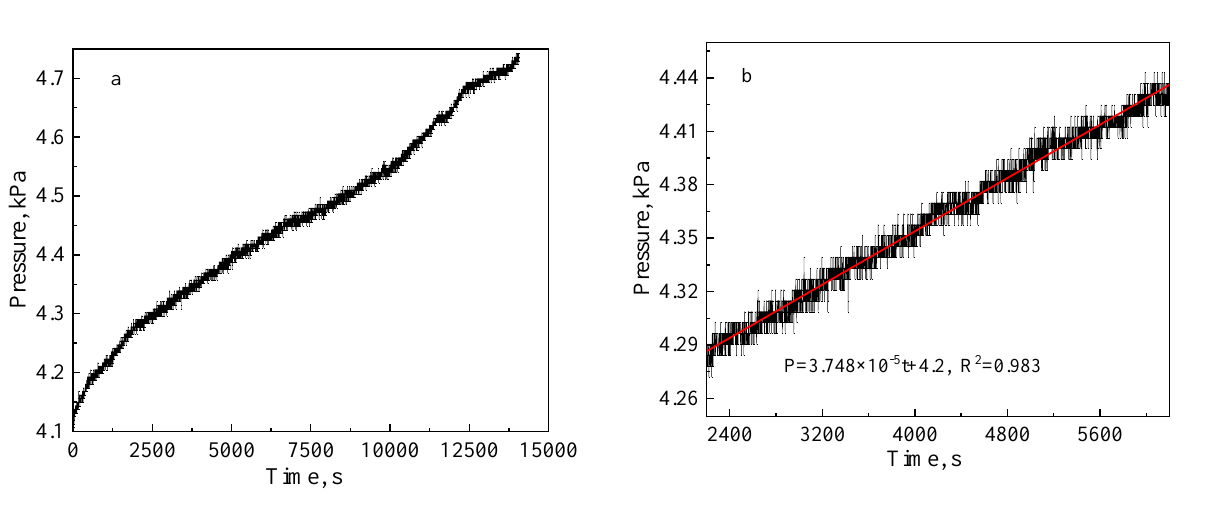
Figure 4. Variation of the measured pressure drop with time during PM 2.5 sampling in an atmospheric environment with haze for ( a ) all data and ( b ) data between 2200 and 6200